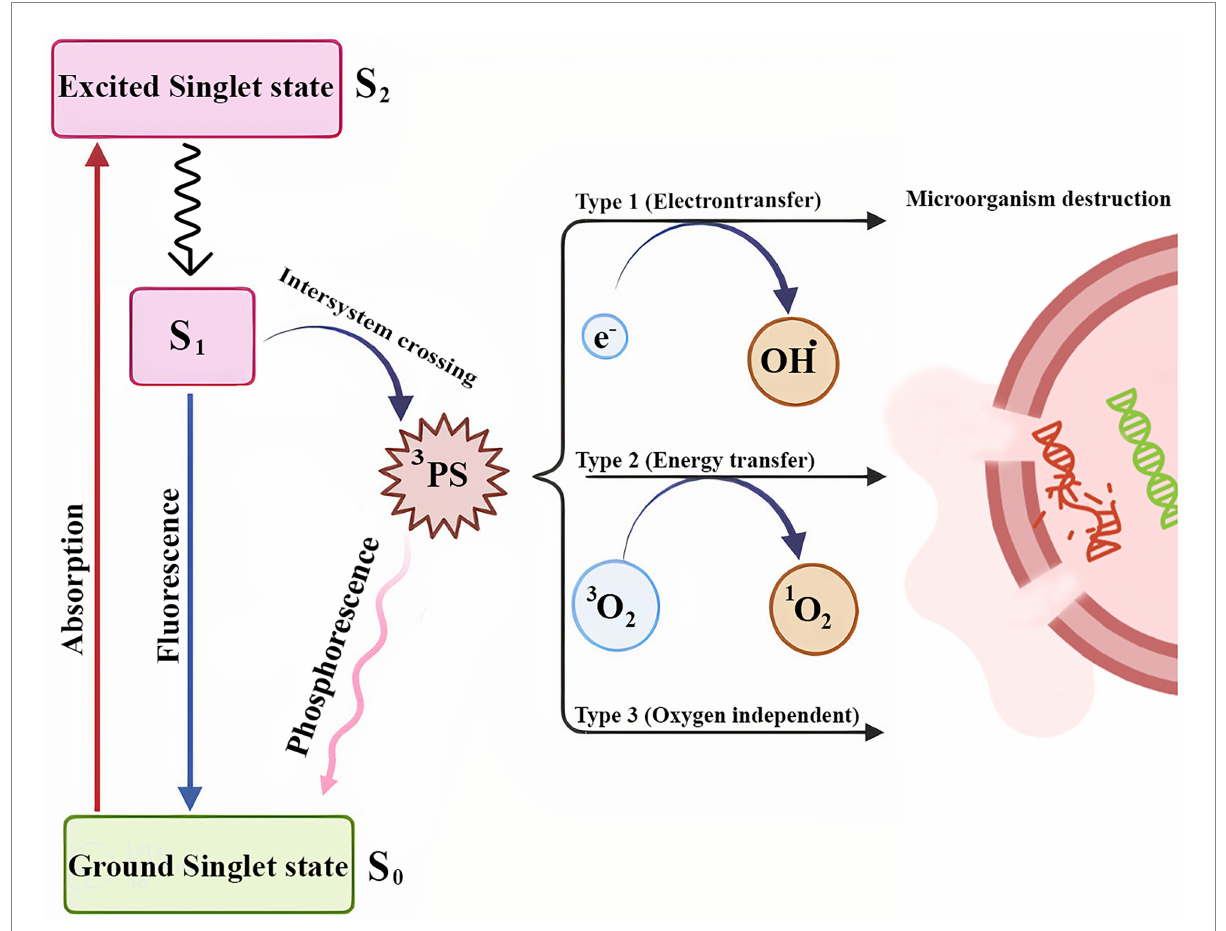
FIGURE 1 Schematic illustration of the three types of photochemical mechanisms involved in